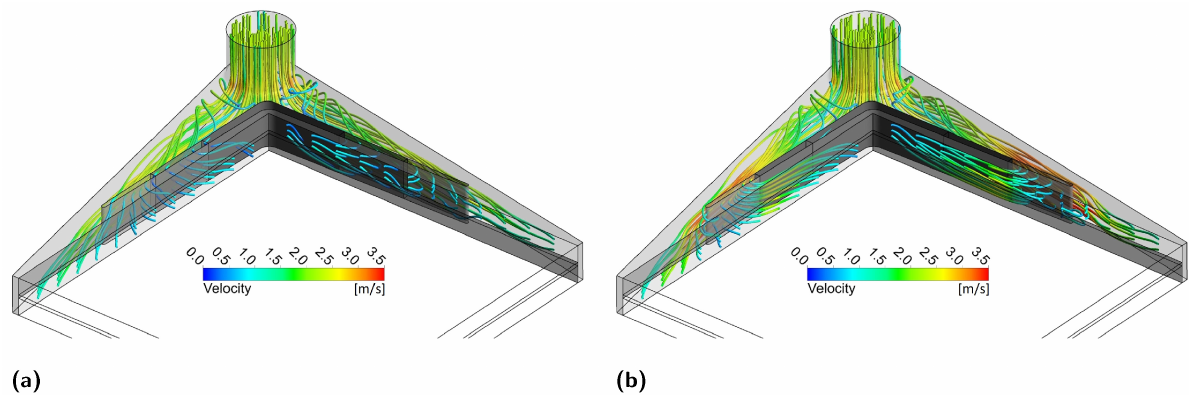
Figure 11. Header with porous baffle: pathlines in the inlet header for u ave = 1.0 m/s and L b = 6.0 mm, colored by velocity magnitude for ( a ) porosity P1 and ( b ) porosity